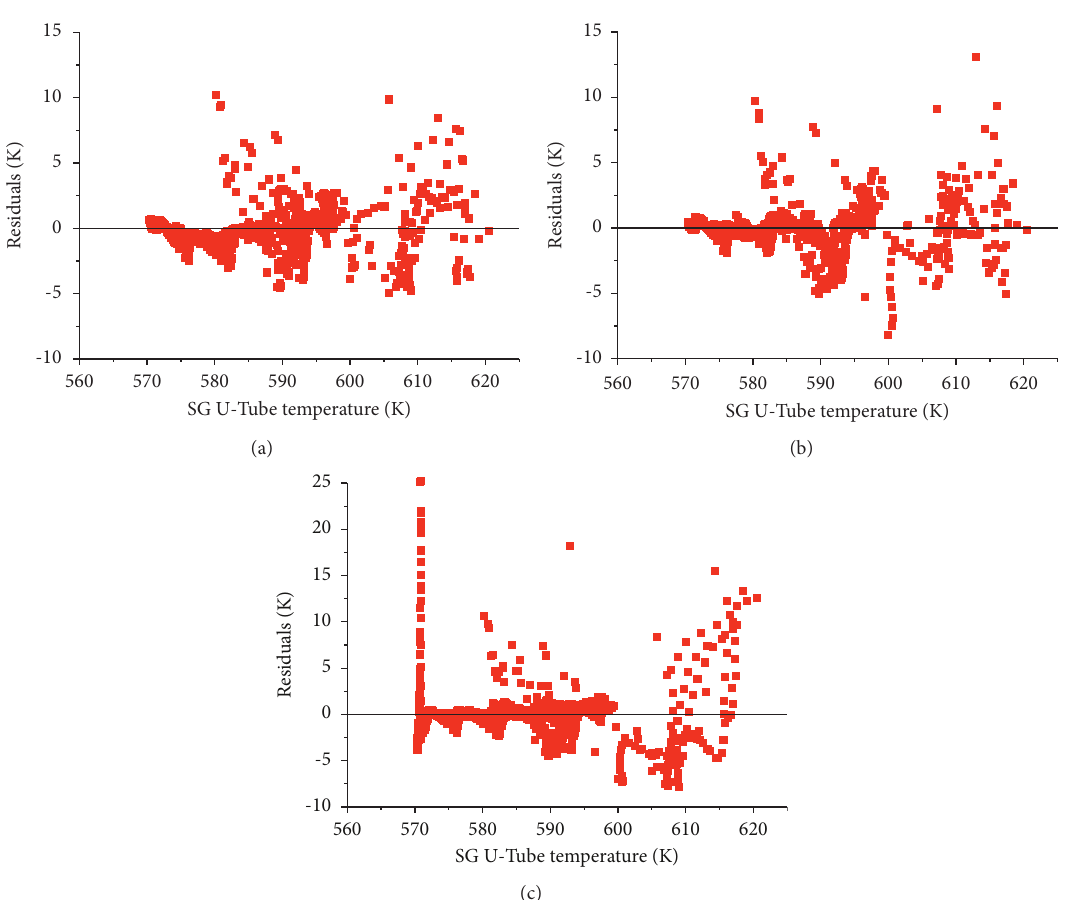
Figure 10: Residual plots of SG U-tube temperature for the ANFIS model (a), RBFN model (b), and LSTM model